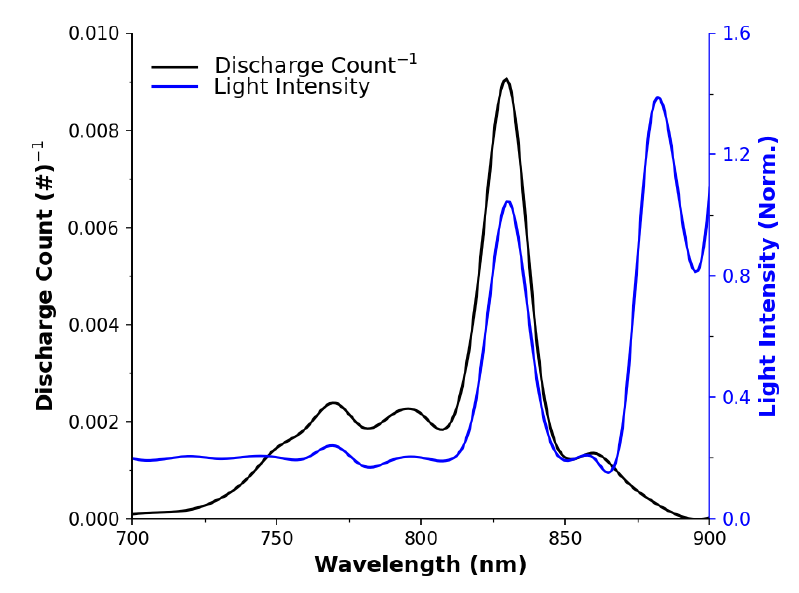
Figure A3. Inverse of discharge counter and light intensity. Figure A4: The resulting spectra is comparatively smooth and featureless, as